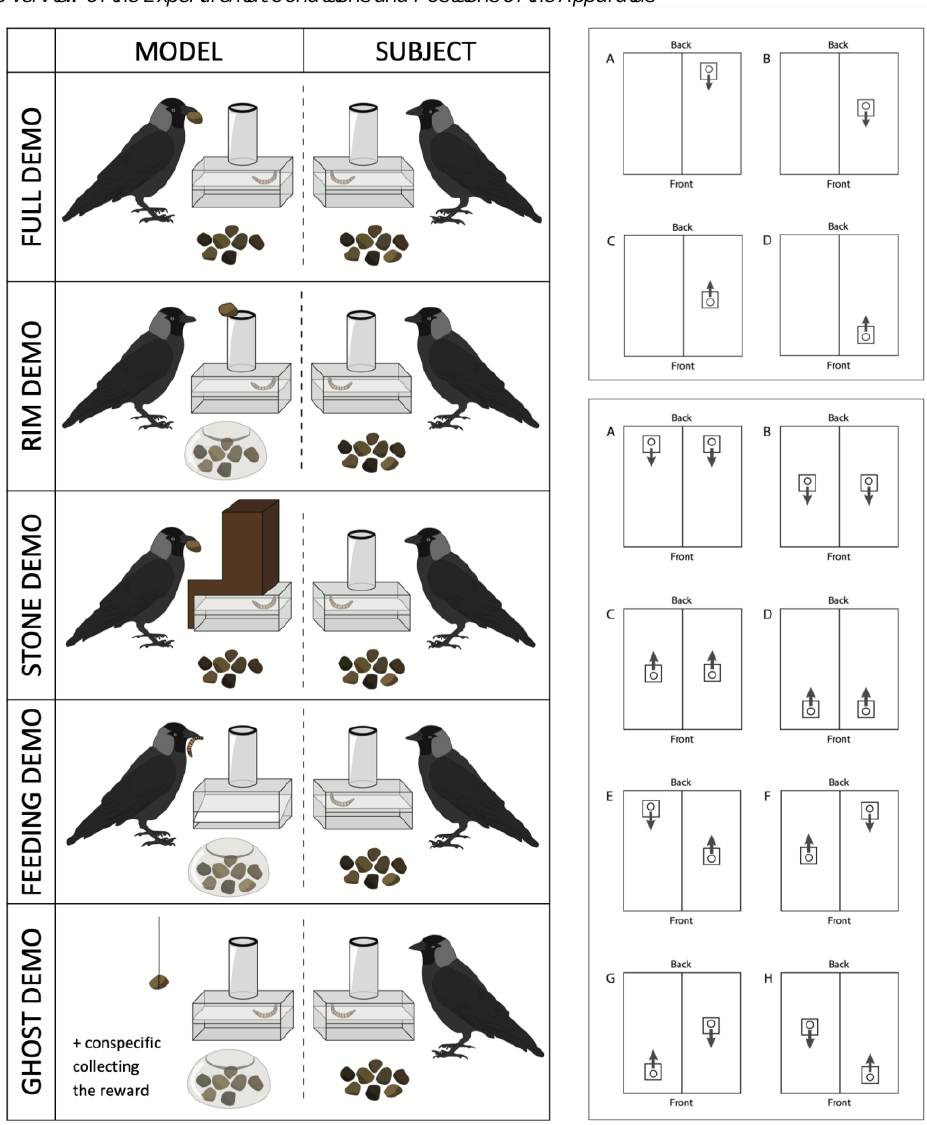
A Graphic Overview of the Experimental Conditions and Positions of the Apparatus